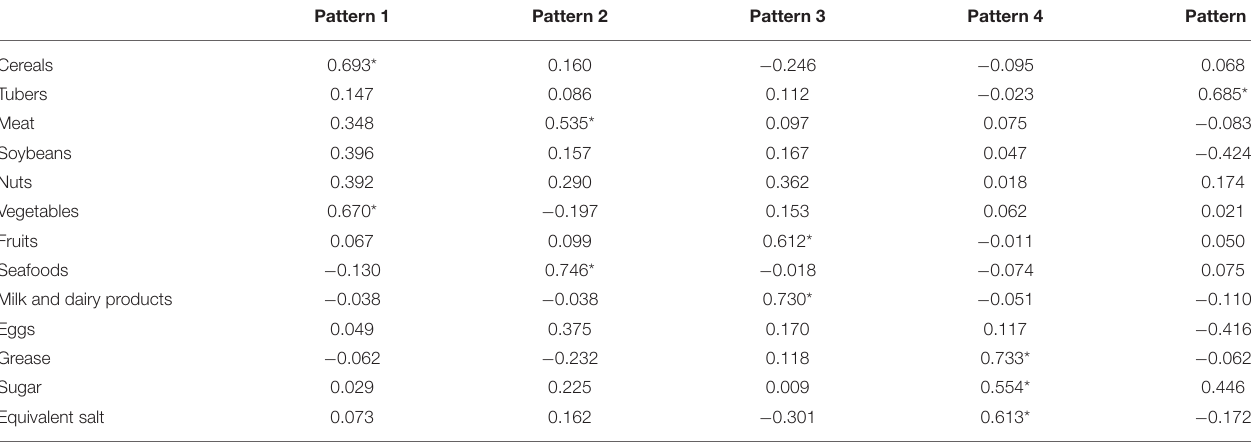
TABLE 3 | Factor-loading matrix for the dietary patterns and food groups.